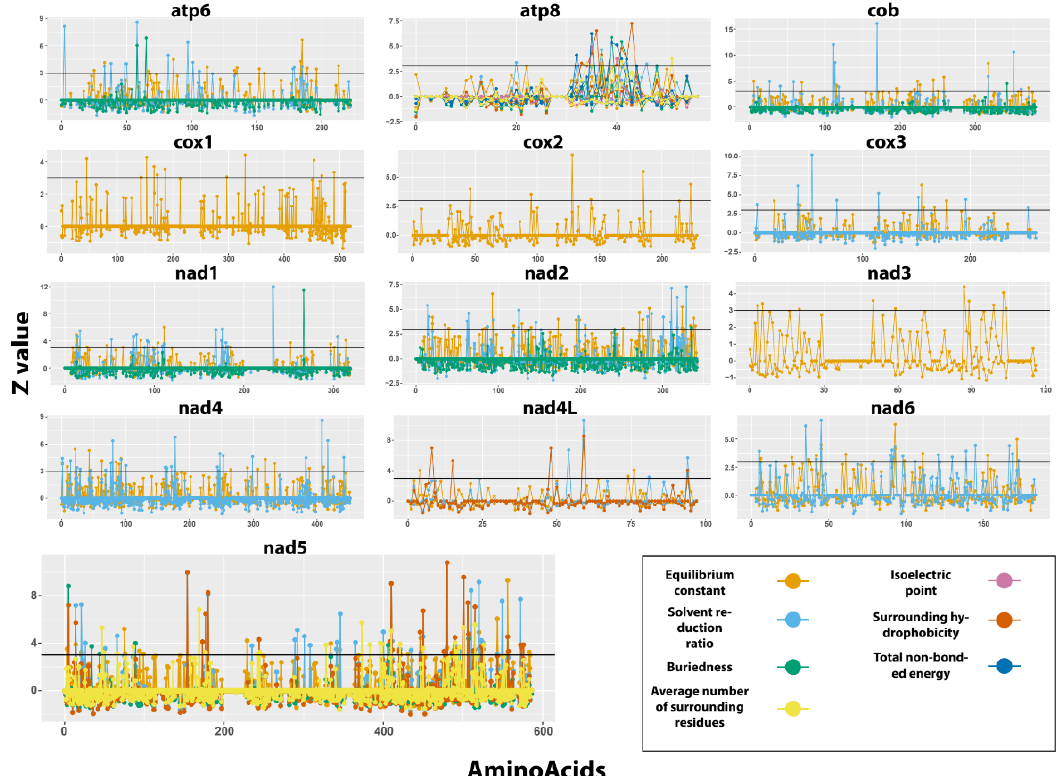
Figure 7. Selection on structural and biochemical amino acid properties of Hyalella mitochondrial PCGs. The x- and y-axis correspond to amino acid sites and Z-score values per site, respectively. The Z -score was calculated for the two most radical magnitude categories considered in TreeSAAP (7 and 8). Colors indicate the different physicochemical characteristics deduced to be under positive selection, as shown in the figure. The horizontal line corresponds to the minimum Z -score value for positive selection to be considered significant at a particular site.